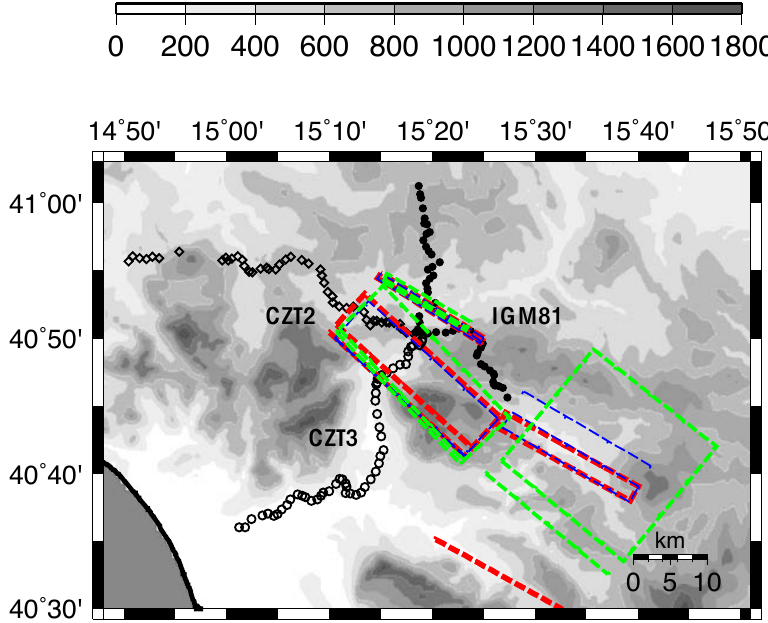
Figure 1. Maps of the study area showing the main fault systems of the 1980 earthquake: (a) Traces of the fault planes: green, Pantosti and Valensise [1990]; cyan, Pingue et al. [1993]; purple, Bernard and Zollo [1989]. Blue thick solid lines, fault scarps identified by Pantosti and Valensise [1990]; red thick solid lines, fault scarps identified by Blumetti et al. [2002]. Triangles, locations of the seismic stations; blue triangle, GL9 station; blue diamond, location of the Bovino accelerometer; black diamonds; epicenters of the earthquakes that occurred in the period of December 1 to 15, 1980. Inset: Location of study area within Italy. (b) Surface projection of the fault planes: green, Dalla Via et al. [2003]; red, Amoruso et al. [2005a], type A; blue, Amoruso et al. [2005a], type B. Black diamonds, location of benchmarks of the CZT2 leveling line; black circles, location of benchmarks of the CZT3 leveling line; black points, location of benchmarks of the IGM81 leveling line used in the present